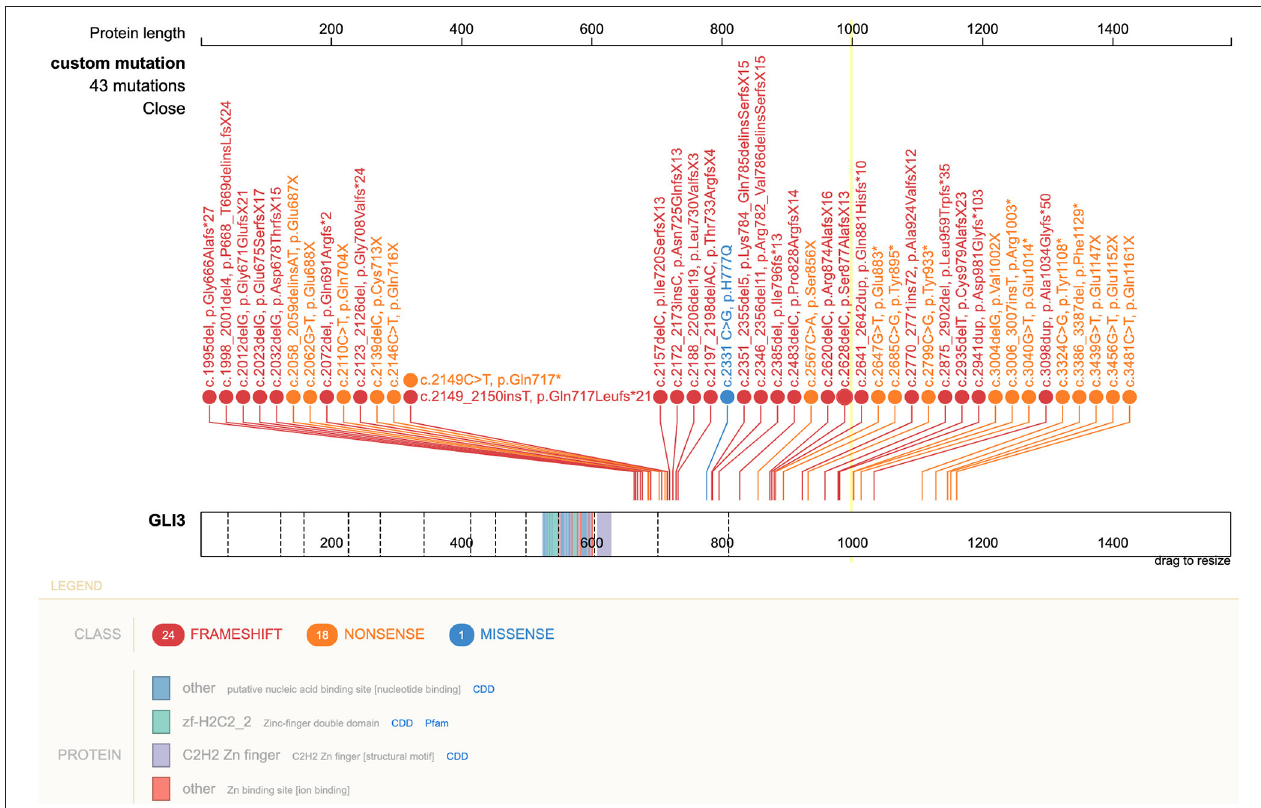
FIGURE 5 | Schematic of GLI3 and pathogenic variants associated with PHS reported to date. The pathogenic variant c.2331 C > G, leading to p.H777Q in GLI3 is shown in blue. Right lower corner insert: GLI3 protein and location of variants. PHS, Pallister–Hall